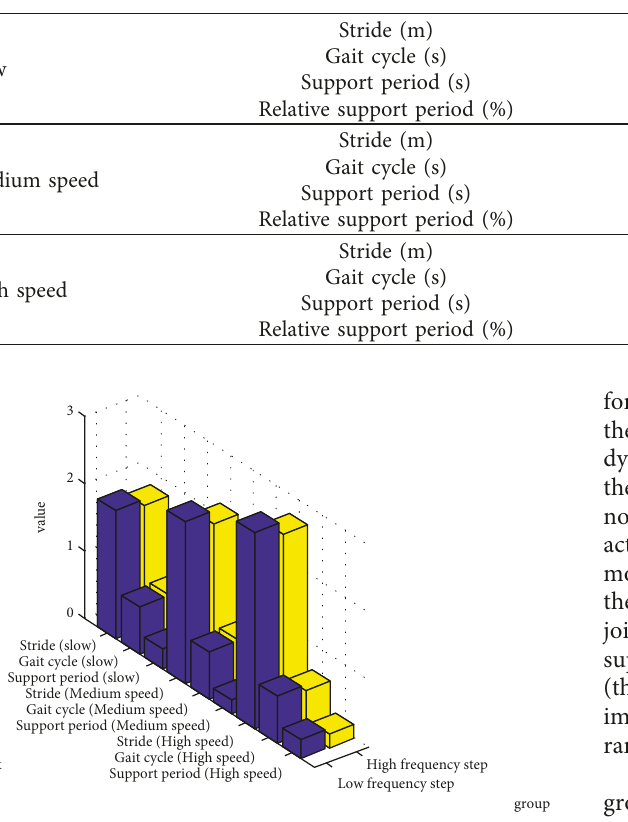
Figure 2: Kinematic indicators at different running